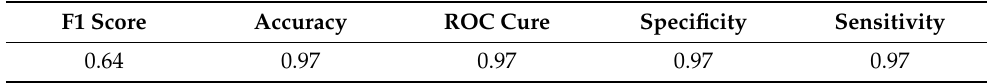
Table 9. Support vector machine result of